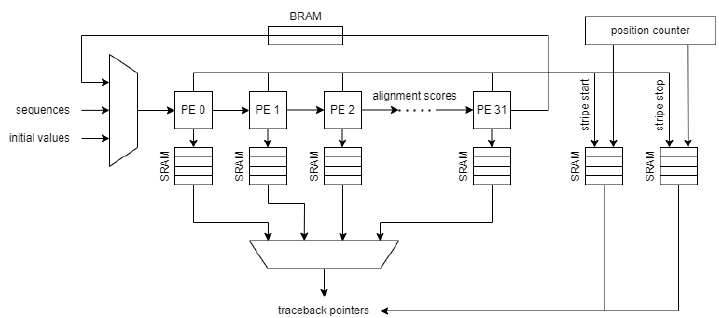
Figure 5. GACT-X’s systolic array architecture with 32 PEs. The host transfers the target and the query sequences to the DRAM. N PE = 32 query characters are loaded to the PEs, and target elements are streamed in a systolic fashion. A fixed memory of 1 BRAM bank per PE is allocated to store the 4-bit trace-back pointers, sequentially—2 bits for the main matrix and 2 bits for gap matrices. The start and stop positions of each stripe are stored in separate